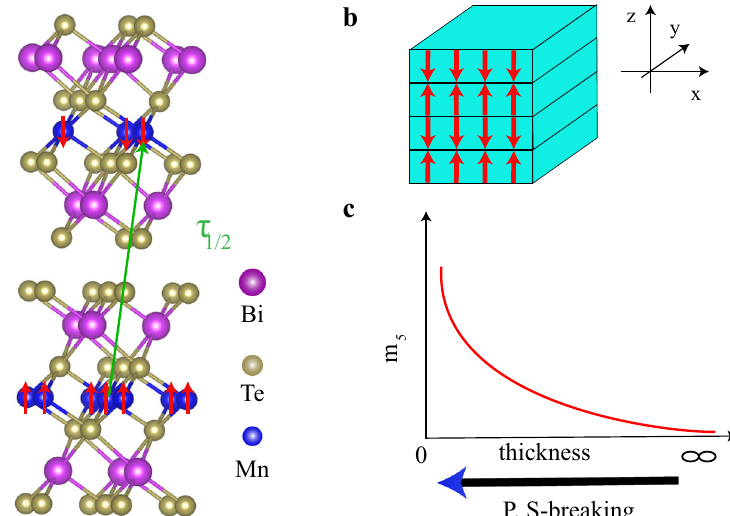
Fig. 1 Schematic of P , S -breaking mass in MnBi 2 Te 4 thin fi lms. a Crystal structure of MnBi 2 Te 4 . The red arrows denote the spin moment of Mn atoms and the green arrows represent the half-translation operator τ 1/2 for the S symmetry. b Schematic of MnBi 2 Te 4 thin fi lms with even septuple layers grown along the easy axis (the z -direction). c Schematic of the P , S -breaking mass m 5 in MnBi 2 Te 4 thin fi lms. m 5 expects to increase when the fi lm thickness decreases due to the P , S